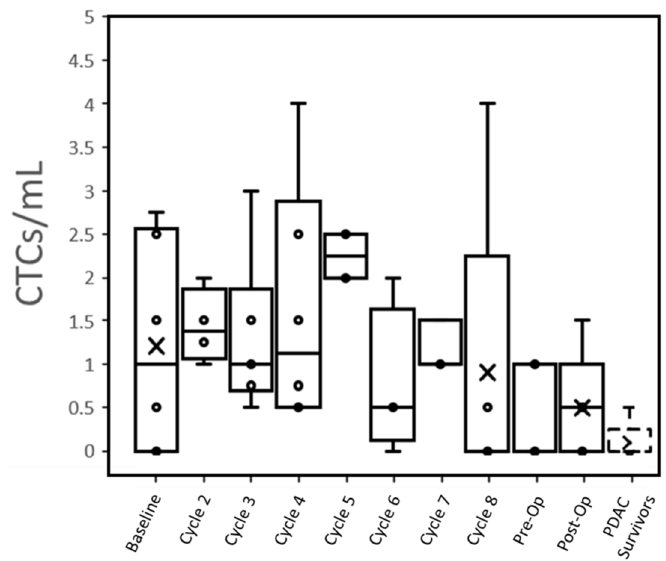
Figure 1. Trend in the CTC number per mL of patient blood samples over the treatment cycles, pre-operation (pre-OP) and post-operation (post-OP). Each treatment cycle is 2 weeks. Patient data was pooled and plotted as a box plot for each cycle. The whiskers represent the minimum and maximum; the box bottom, the bar inside the box, and the box top represent lower quartile, median, and upper quartile; the cross represents the average; and each circle represents one or multiple datapoints depending on if CTC numbers are overlapping (see the detail in Figures S7–S13). PDAC: pancreatic ductal adenocarcinoma.